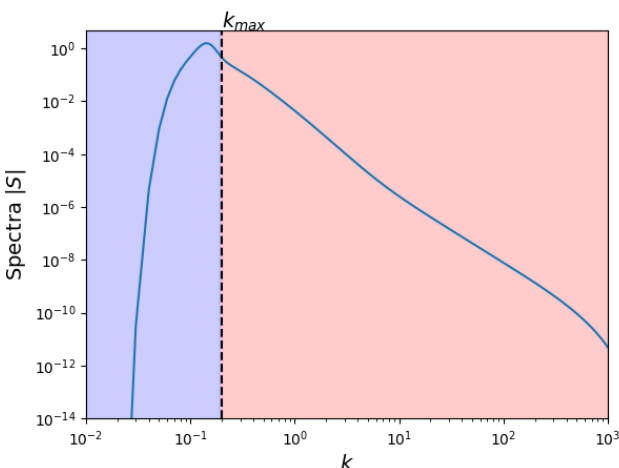
Figure 2. Splitting of the Elfouhaily spectrum. The red and blue parts correspond to the high and low roughness parts,